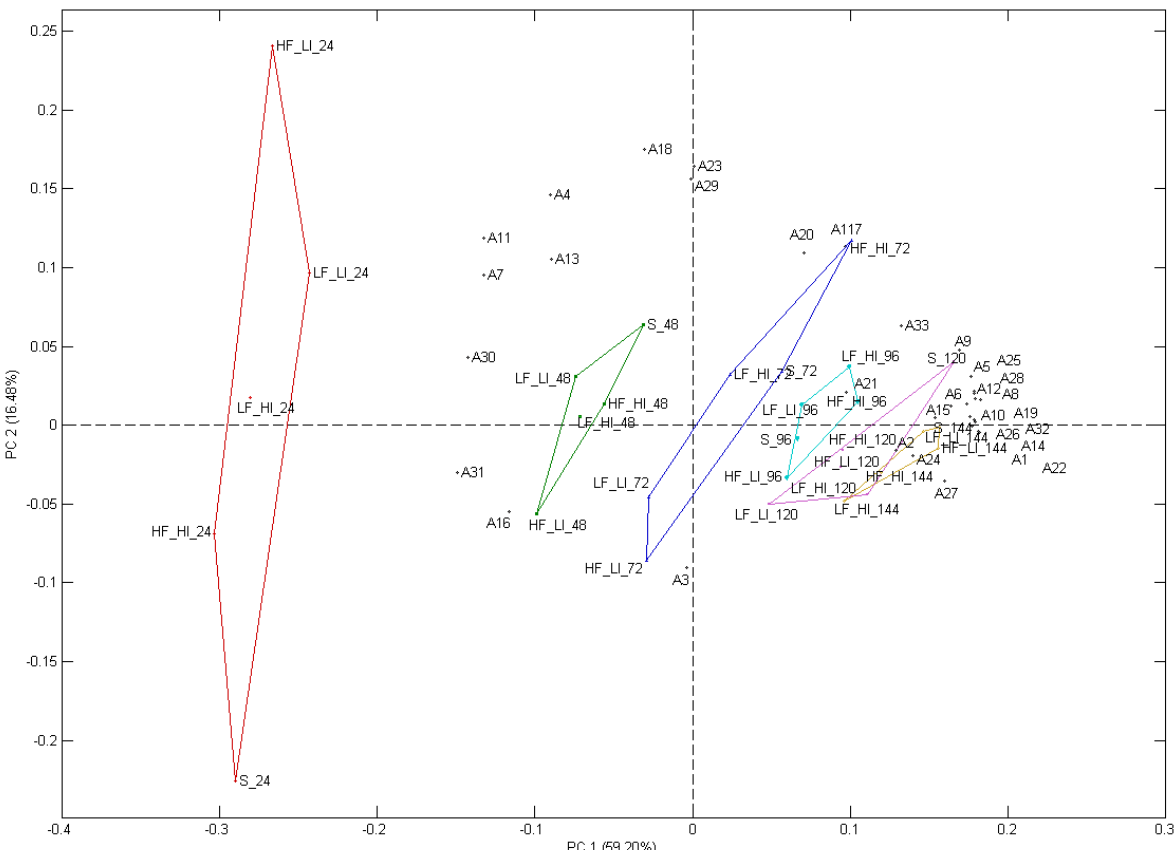
Figure 7. Biplots of the principal component analysis of the VOCs for sequential time intervals in beer brewed under five different sound treatments including a silent control. The numbers representing the volatile organic compounds matches the numbers used in Table A1. Low-frequency and low-intensity (LF_LI); low-frequency and high-intensity (LF_HI); high- frequency and low-intensity (HF_LI); high-frequency and high-intensity (HF_HI), (S) Silence–control.